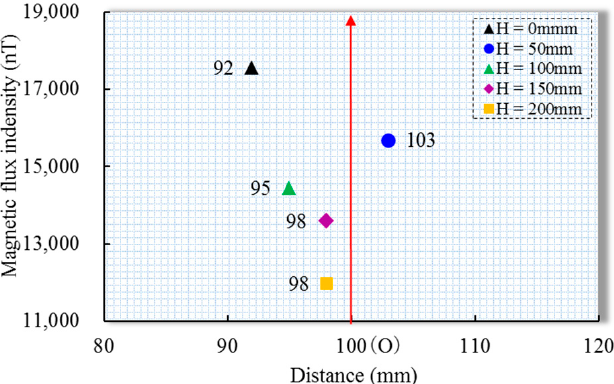
Figure 12. Comparison of the location of the peak of the measured normal component and the center of the stress concentration zone at different lift-offs.